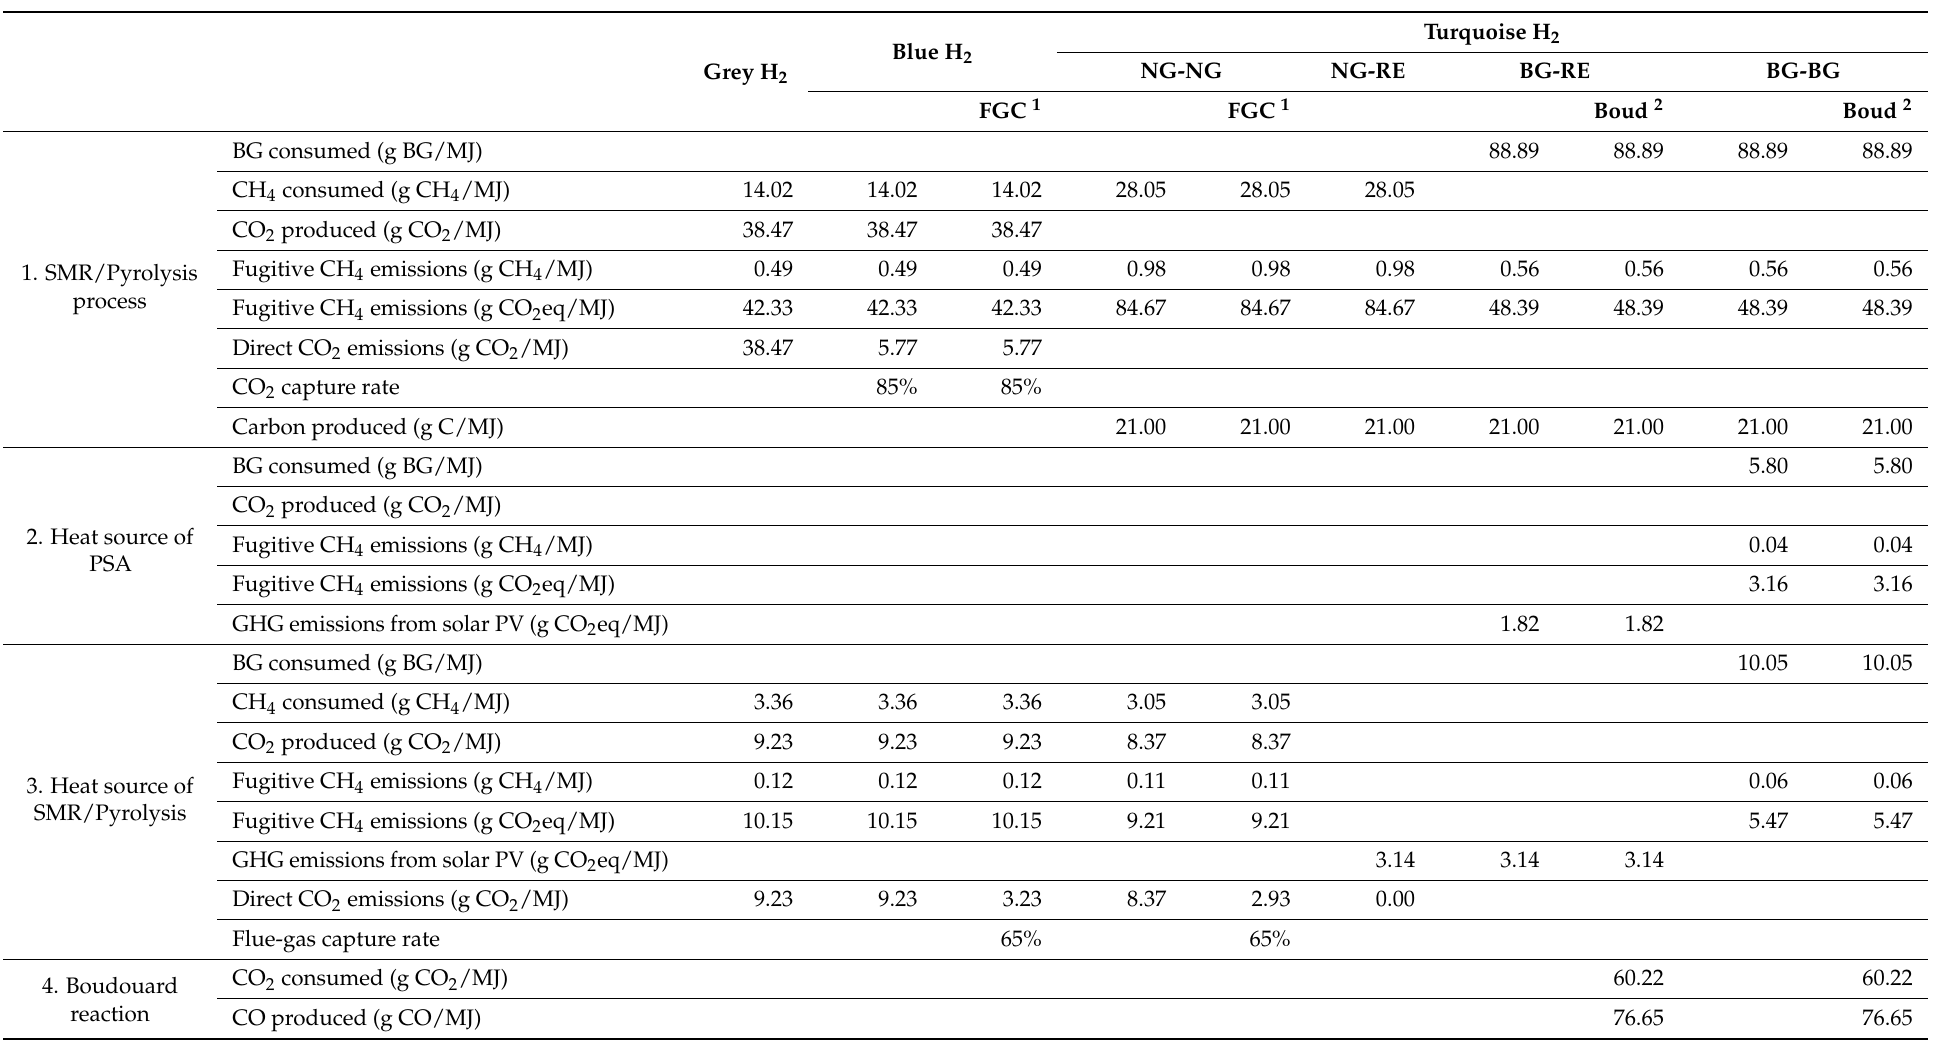
Table 2. Comparison of feedstock consumption and emissions from grey, blue, and turquoise